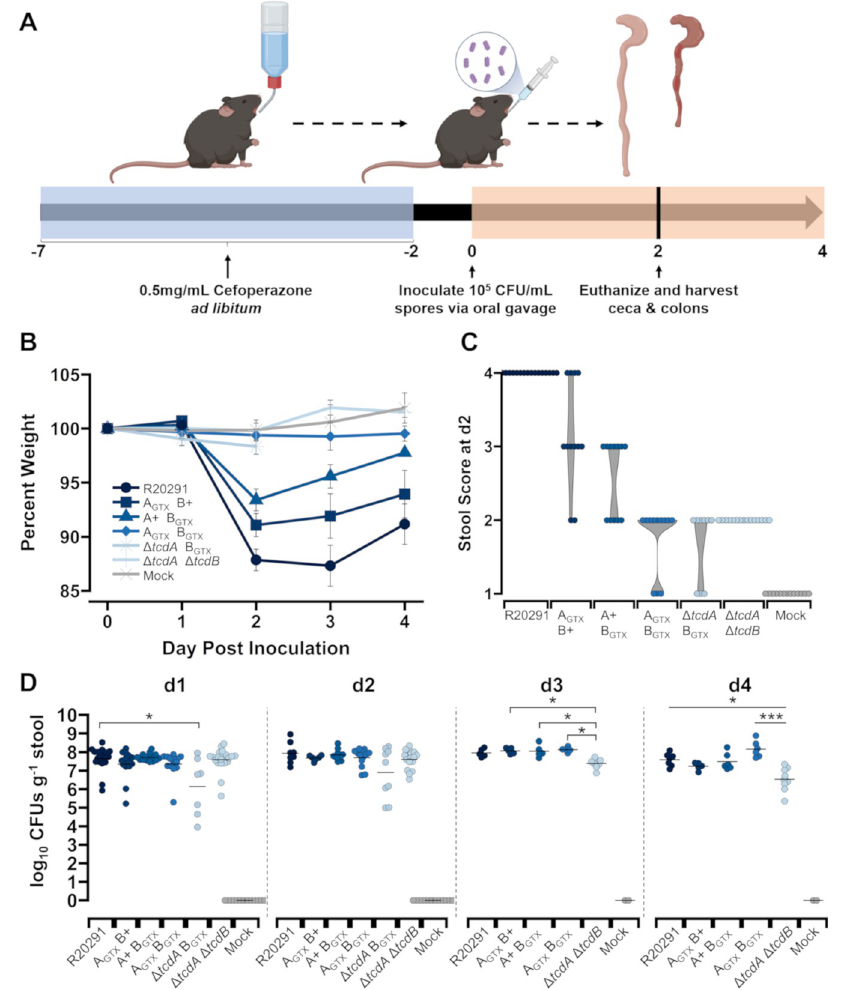
Fig 2. GT-dependent and independent effects on weight loss, diarrhea, and colonization in the mouse model of C . difficile infection. (A) Visual abstract of the cefoperazone mouse model of CDI used for this study. The figure was created with BioRender (B) Percent weight loss from day 0 for R20291 ( n = 22), A GTX B+ ( n = 15), A+ B GTX ( n = 15), A GTX B GTX ( n = 15), Δ tcdA B GTX ( n = 9), Δ tcdA Δ tcdB ( n = 22), and mock ( n = 13). Points represent group averages at each day and error bars denote standard error of the mean. (C) Stool scores at 2 dpi. (D) Daily C. difficile burden in stool. Each point is an individual mouse, and the crossbars represent group daily means. Significantly different groups as determined by Dunn’s test are shown in brackets ( � p < 0.05; ��� p < 0.001).